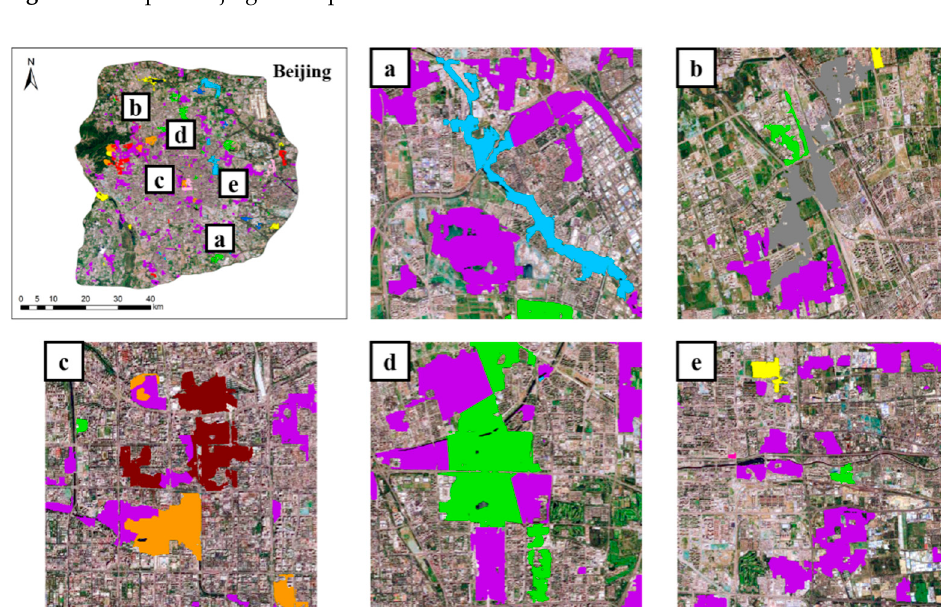
Figure 14. Local details of Beijing urban park map ( a – e ).